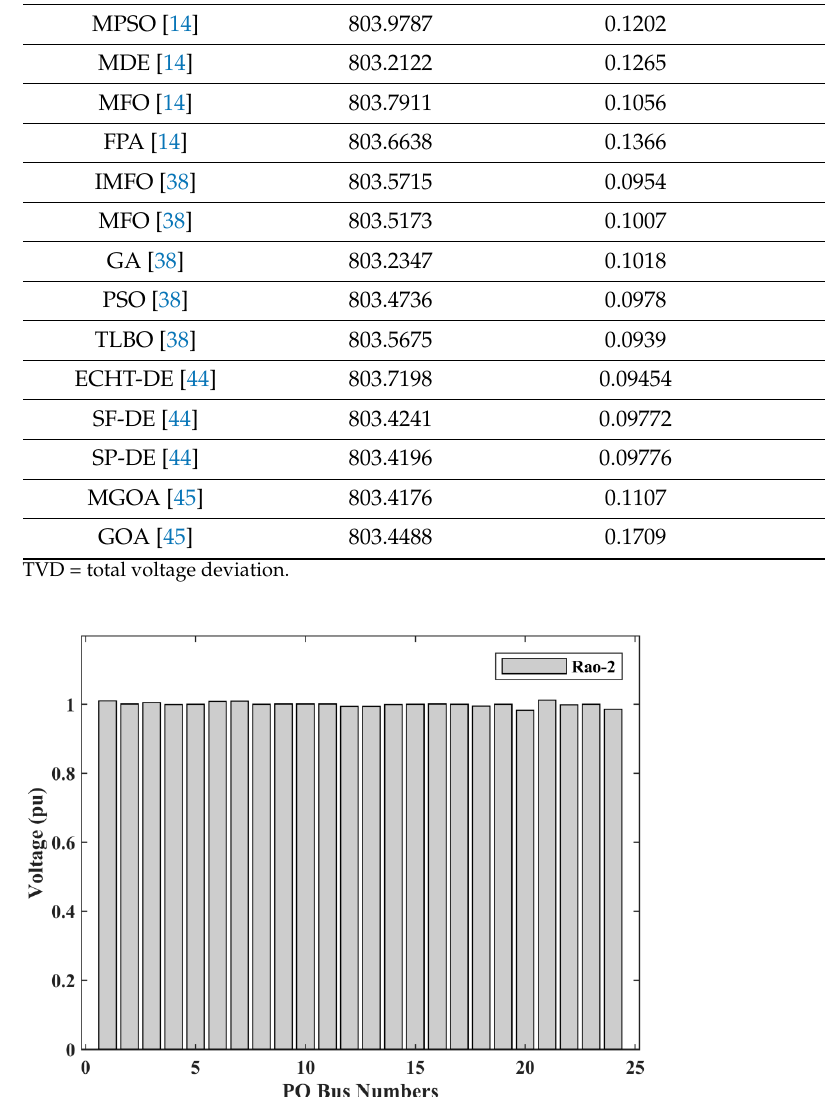
Table 4. Case 2: VPI in the IEEE 30-bus system.